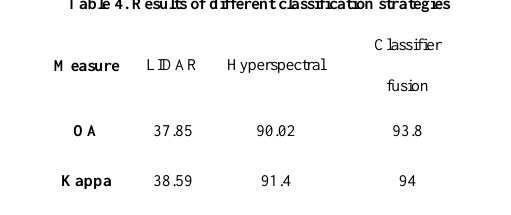
Table 4. Results of different classification strategies